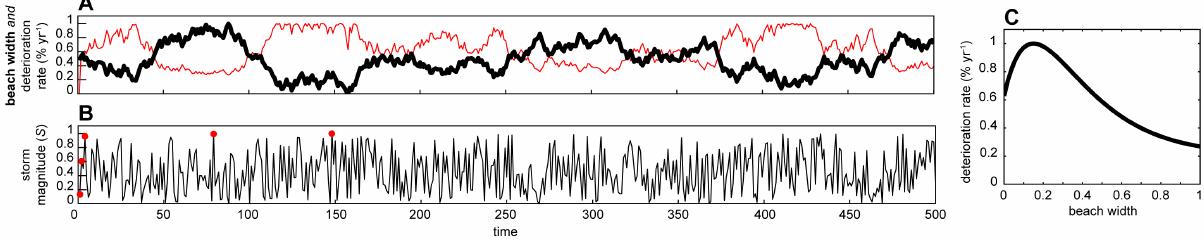
Figure 2. Forcing components for the seawall model. (A) Normalized Brownian signal representing beach width over time (bold) and the corresponding wall deterioration rate (red). (B) Randomized time series of storm events over the simulation period (500yr); red dots mark record-setting storms. (C) Plot of wall deterioration rate as a function of beach width, motivated by Limber and Murray (2011), Strudley et al. (2006), and Anderson (2002).